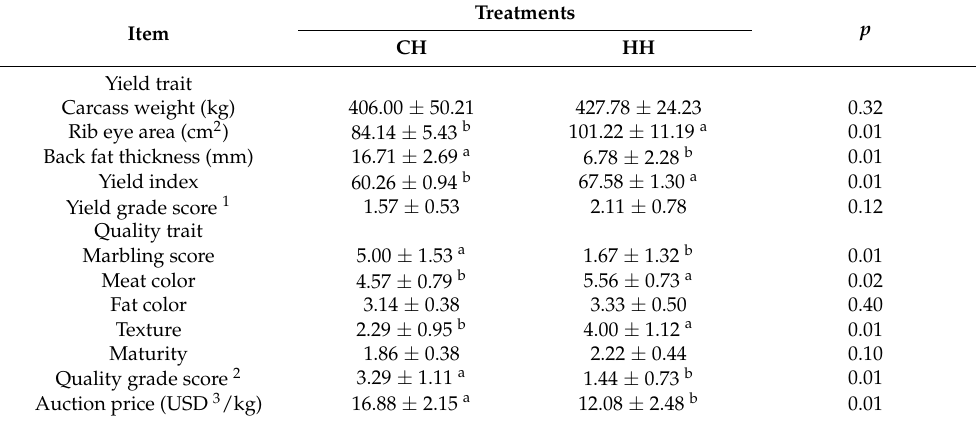
Figure 1. Concentration of serum metabolites and testosterone of castrated (CH: □ ) and hemicas- trated (HH: ■ ) Hanwoo (* = p < 0.05; mean ± SD). Castration ( ▼ ) was performed at seven months of age. Serum testosterone levels were measured only up to 16 months of age. Table 3. Comparison of carcass traits on castrated and hemi-castrated